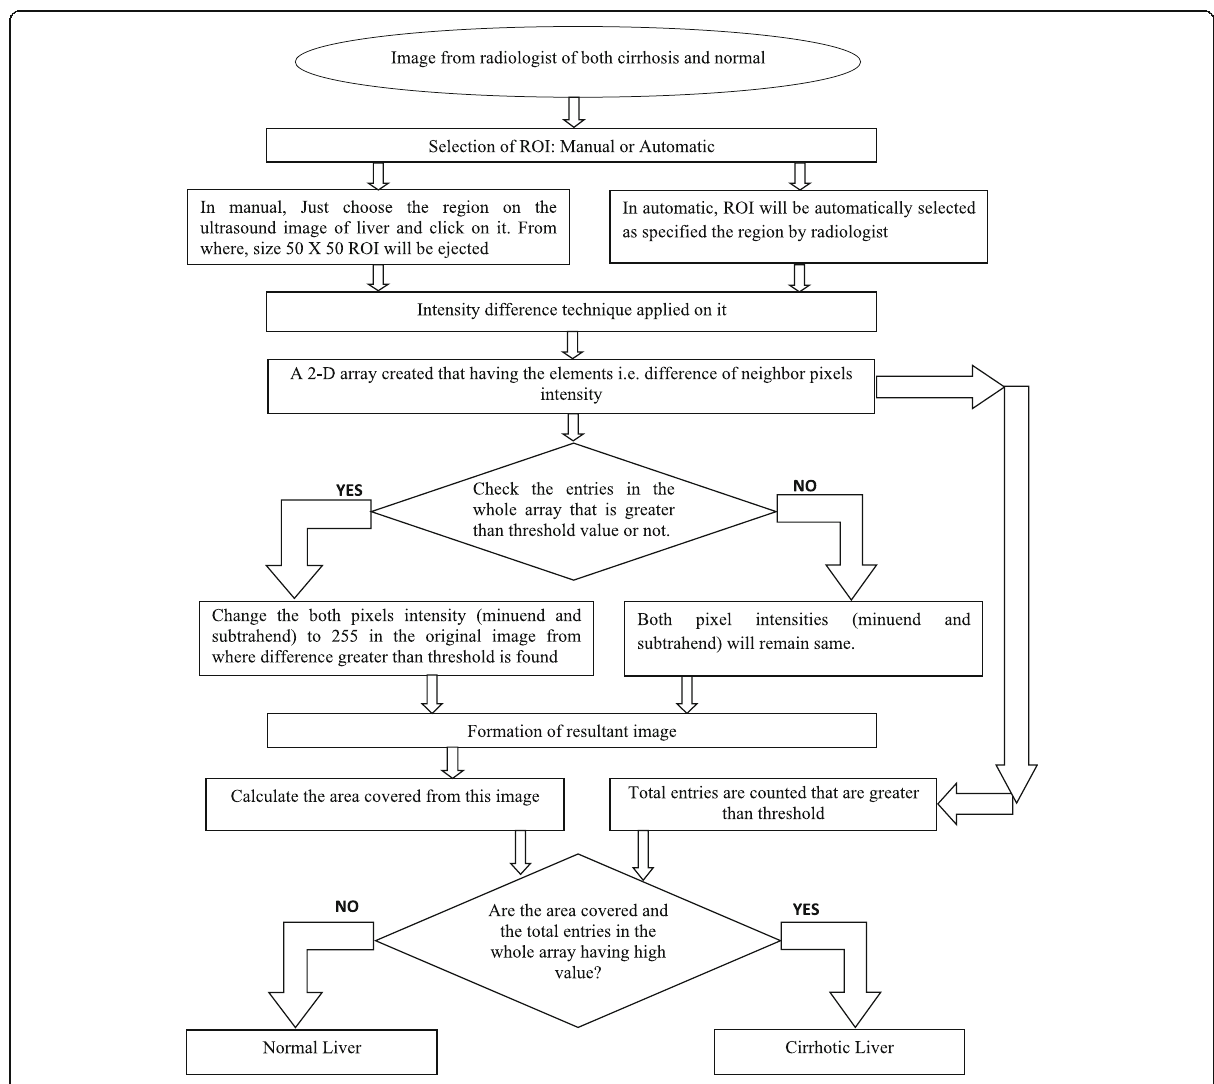
Fig. 3 Flow chart of the proposed